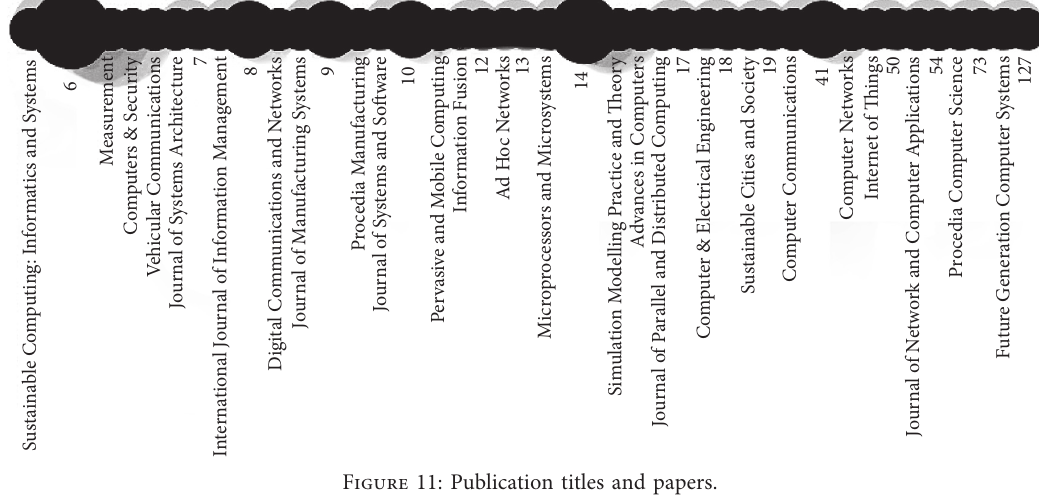
Figure 11: Publication titles and papers.